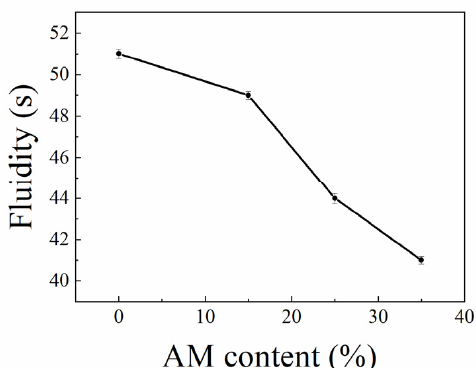
Figure 10. Effect of the AM content on the fluidity of the